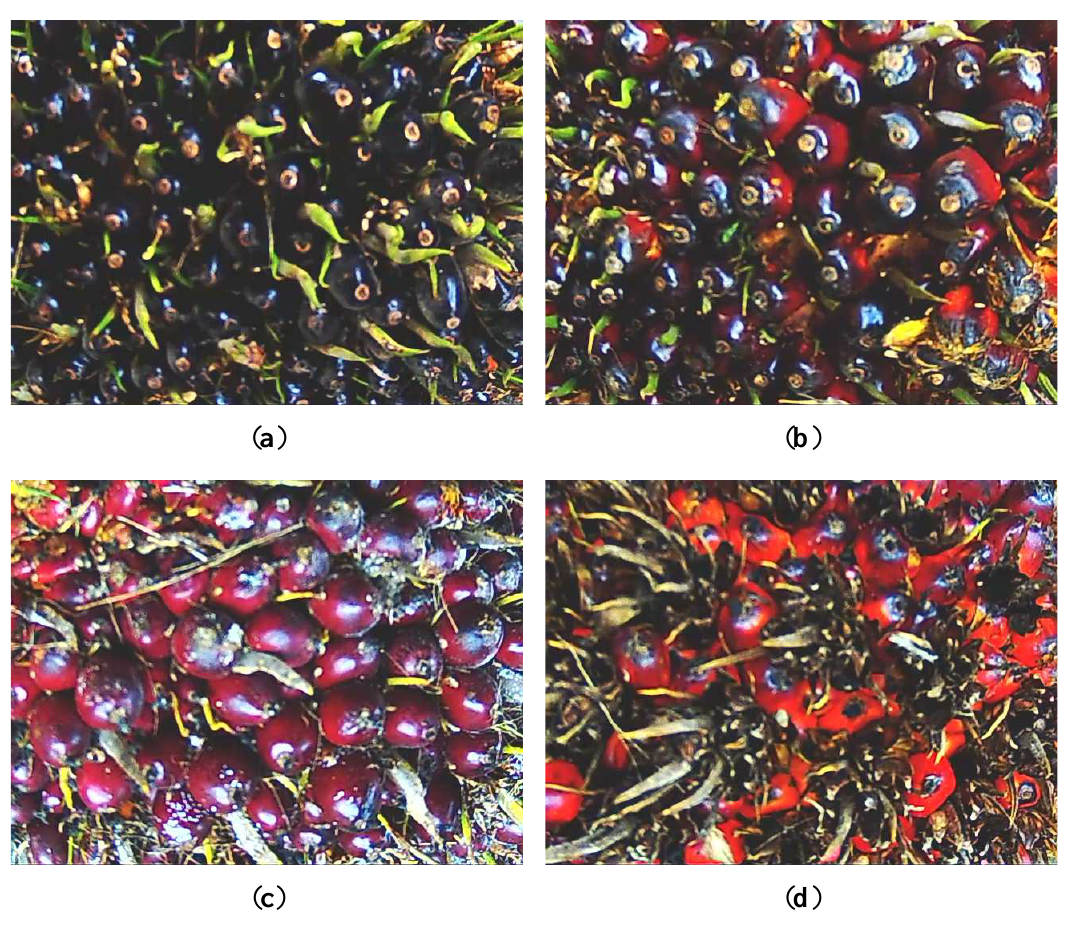
Figure 2. Oil palm FFB images for four ripeness categories: ( a ) Unripe; ( b ) Underripe; ( c ) Ripe; ( d )